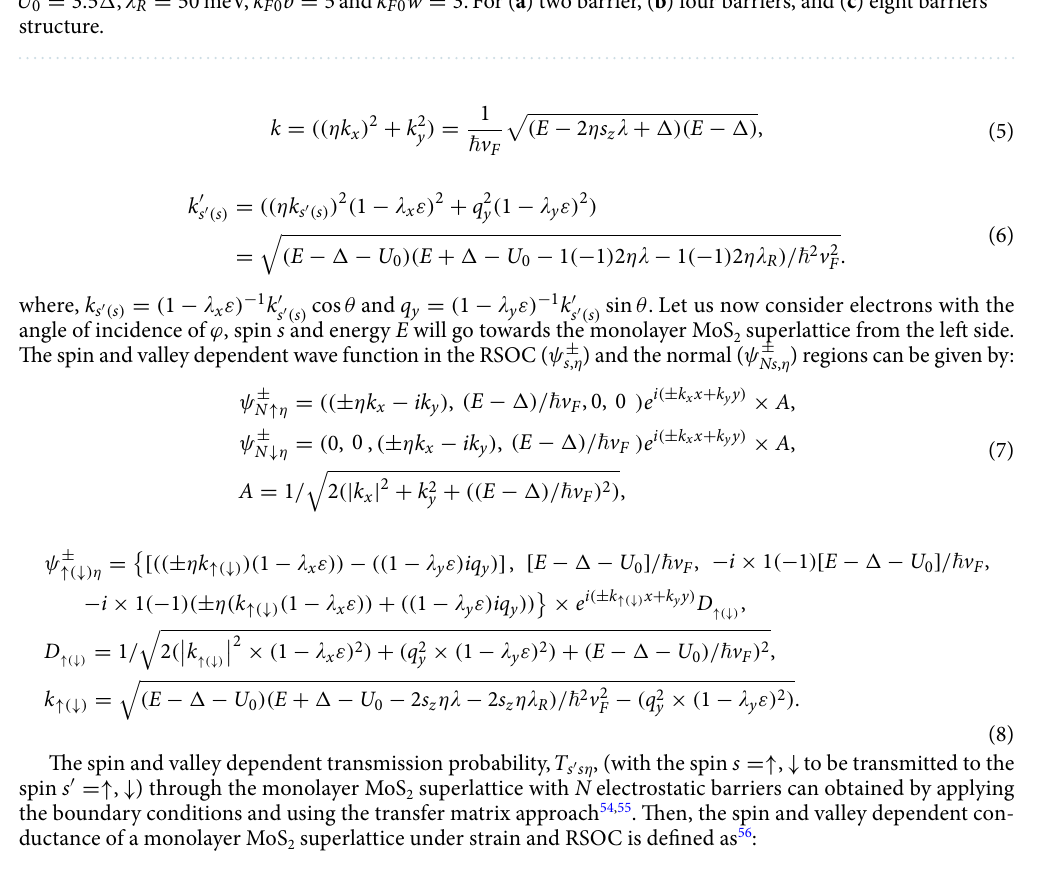
Figure 2. The spin dependent conductance for valley K 1 as a function of strain strength ( ε ), for fixed E = 1.5 (cid:31) , = 3.5 (cid:31) , (cid:31) R = 50 meV, k F U 0